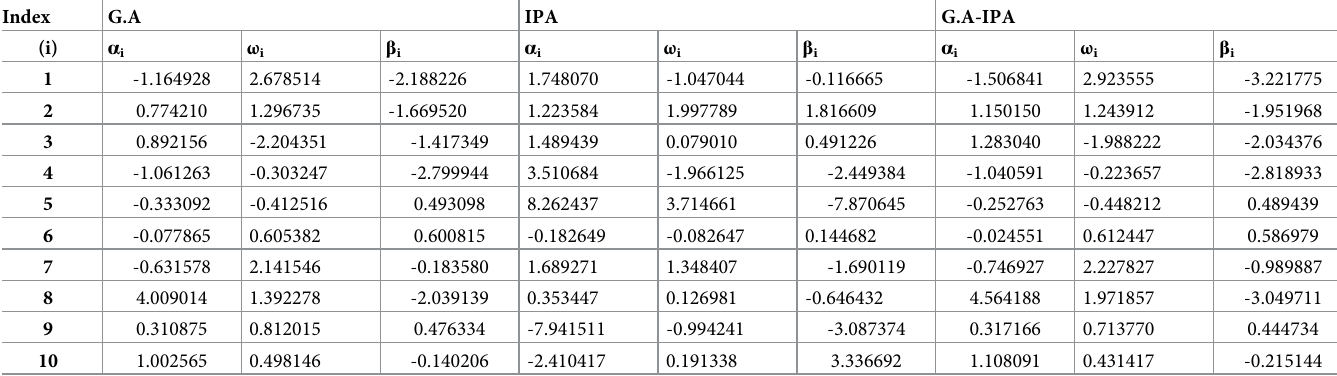
Table 4. Unknown parameters achieved by GA, IPA and GA-IPA for δ = 2.0.